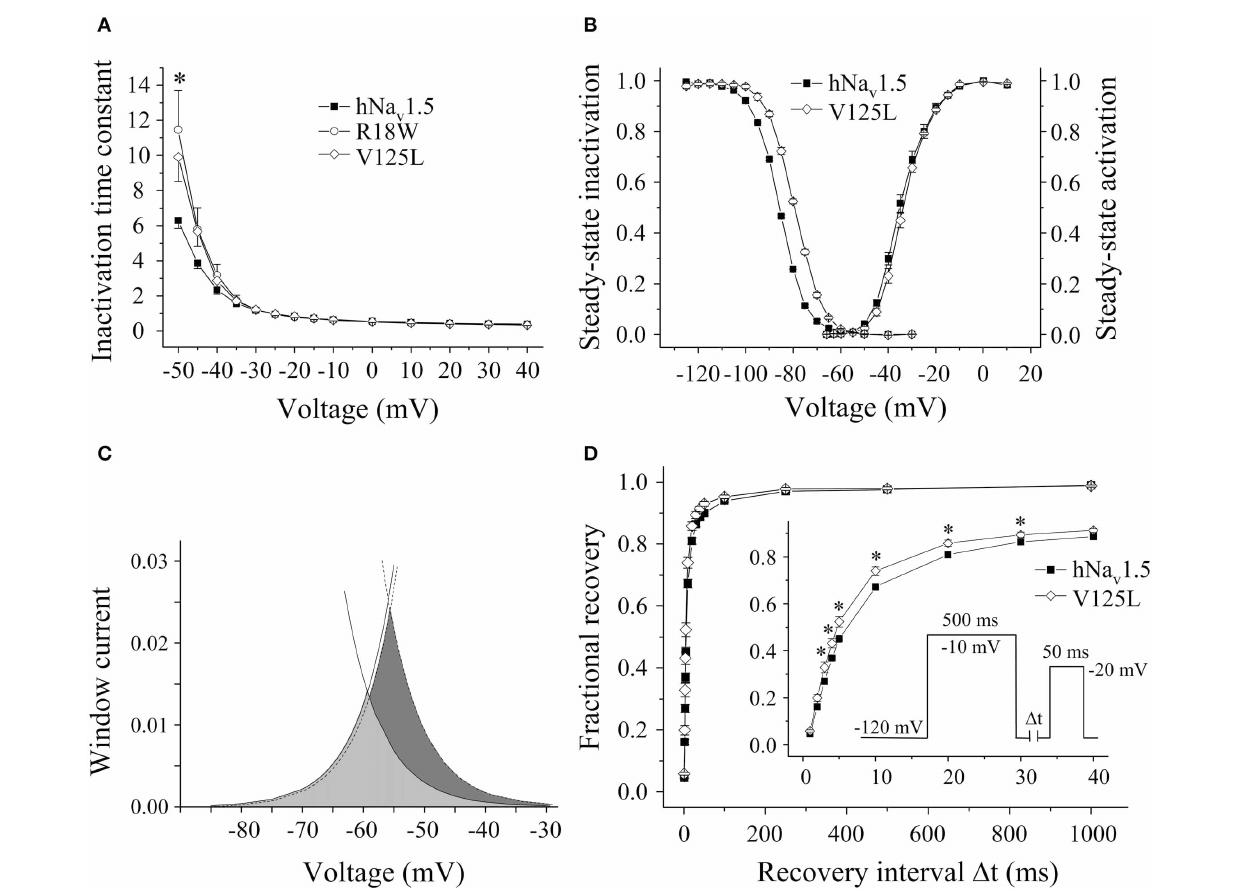
(B) Steady-state activation and inactivation in V125L channels. The figure shows the mean of 4 representative measurements for each. (C) Window current in hNa v 1.5 (grey area, solid lines) and V125L (dark grey area, dotted lines). (D) Recovery from inactivation was accelerated in V125L ( ∗ indicates p < 0 . 05 vs. hNa v 1.5). For individual values see Table 2 .